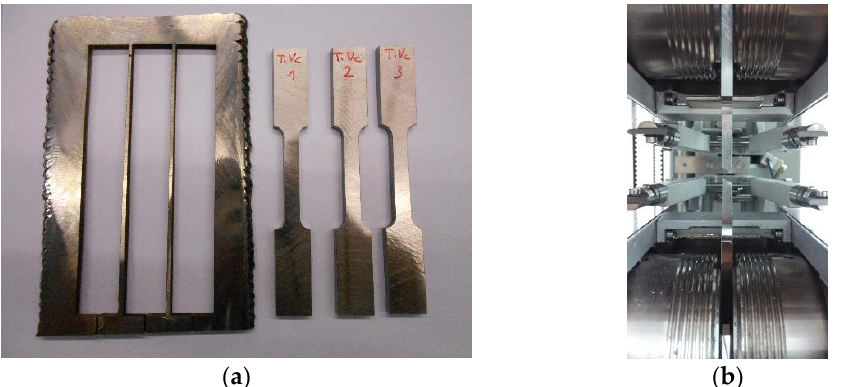
Figure 9. Tensile specimens: ( a ) extracted tensile test specimens for tensile testing and ( b ) a specimen in the testing machine.